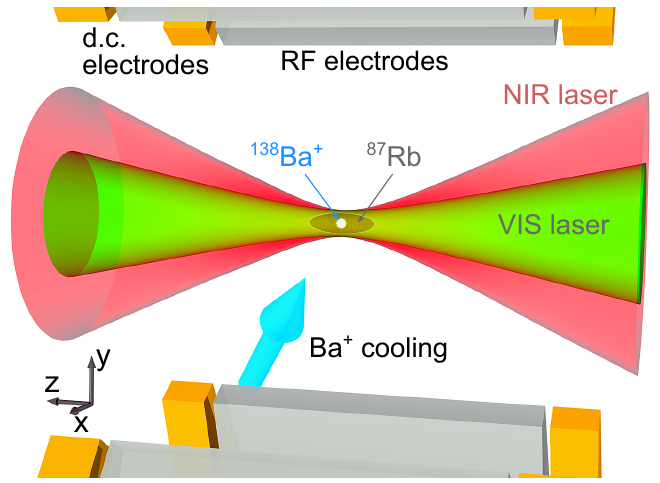
Figure 1. Schematic of the experimental setup. Bichromatic dipole traps (biODT) comprised of two lasers, VIS and NIR, are used to simultaneously trap a 138 Ba + ion and a cloud of ultracold 87 Rb atoms. From Schmidt, Weckesser, Thielemann, Schaetz, and Karpa (2020) [41].